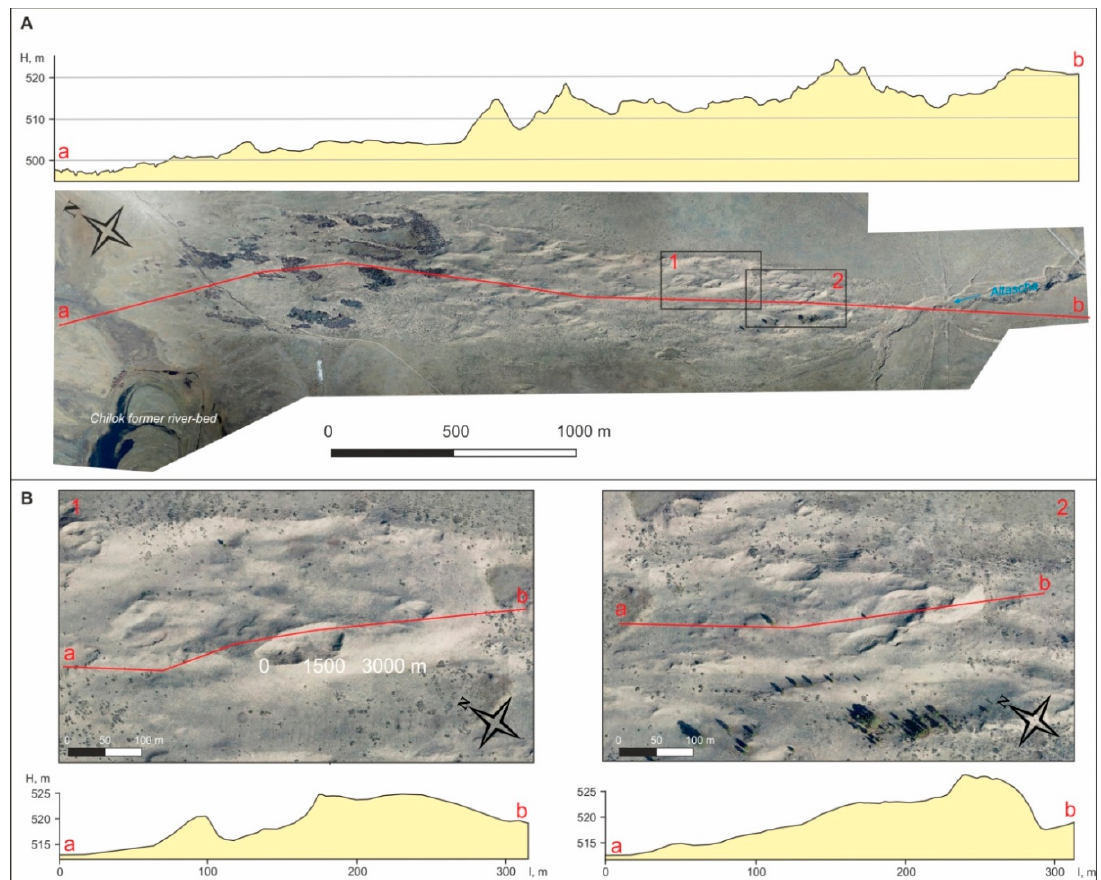
Figure 6. Aeolian relief in the mouth of the valley of the Altasha river (the Khilok valley, Selenga middle mountains). Orthophotomaps and hypsometric profiles: A —of the main aeolian massif, B — of separate dunes.